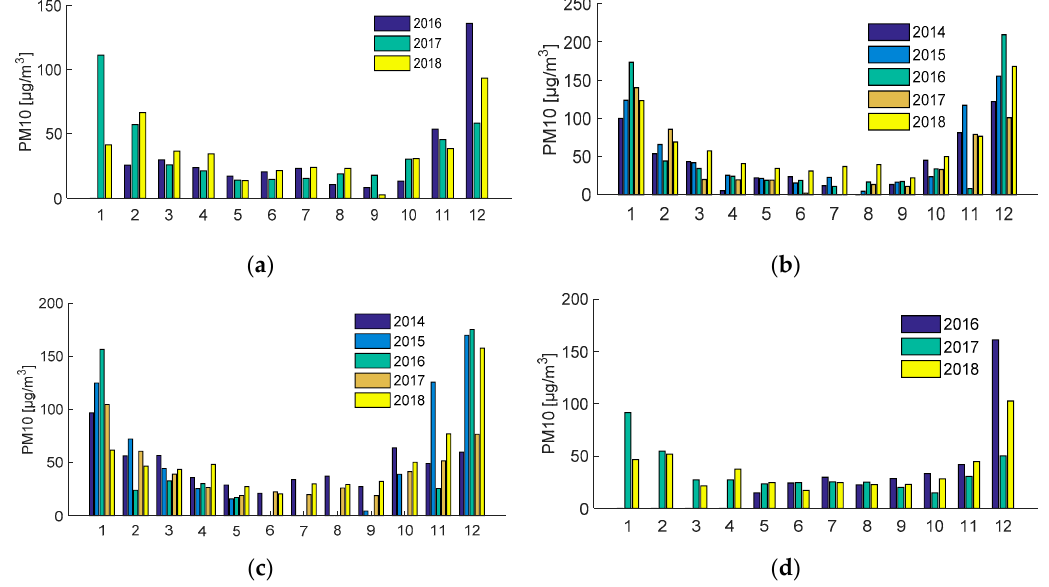
Figure 2. Mean values by months of PM10 pollutant: ( a ) Bjelava measuring station for 2016, 2017 and 2018: ( b ) Ilidža measuring station for 2014, 2015, 2016, 2017 and 2018: ( c ) Otoka measuring station for 2014, 2015, 2016, 2017 and 2018: ( d ) City Hall-measuring station for 2016, 2017 and 2018.